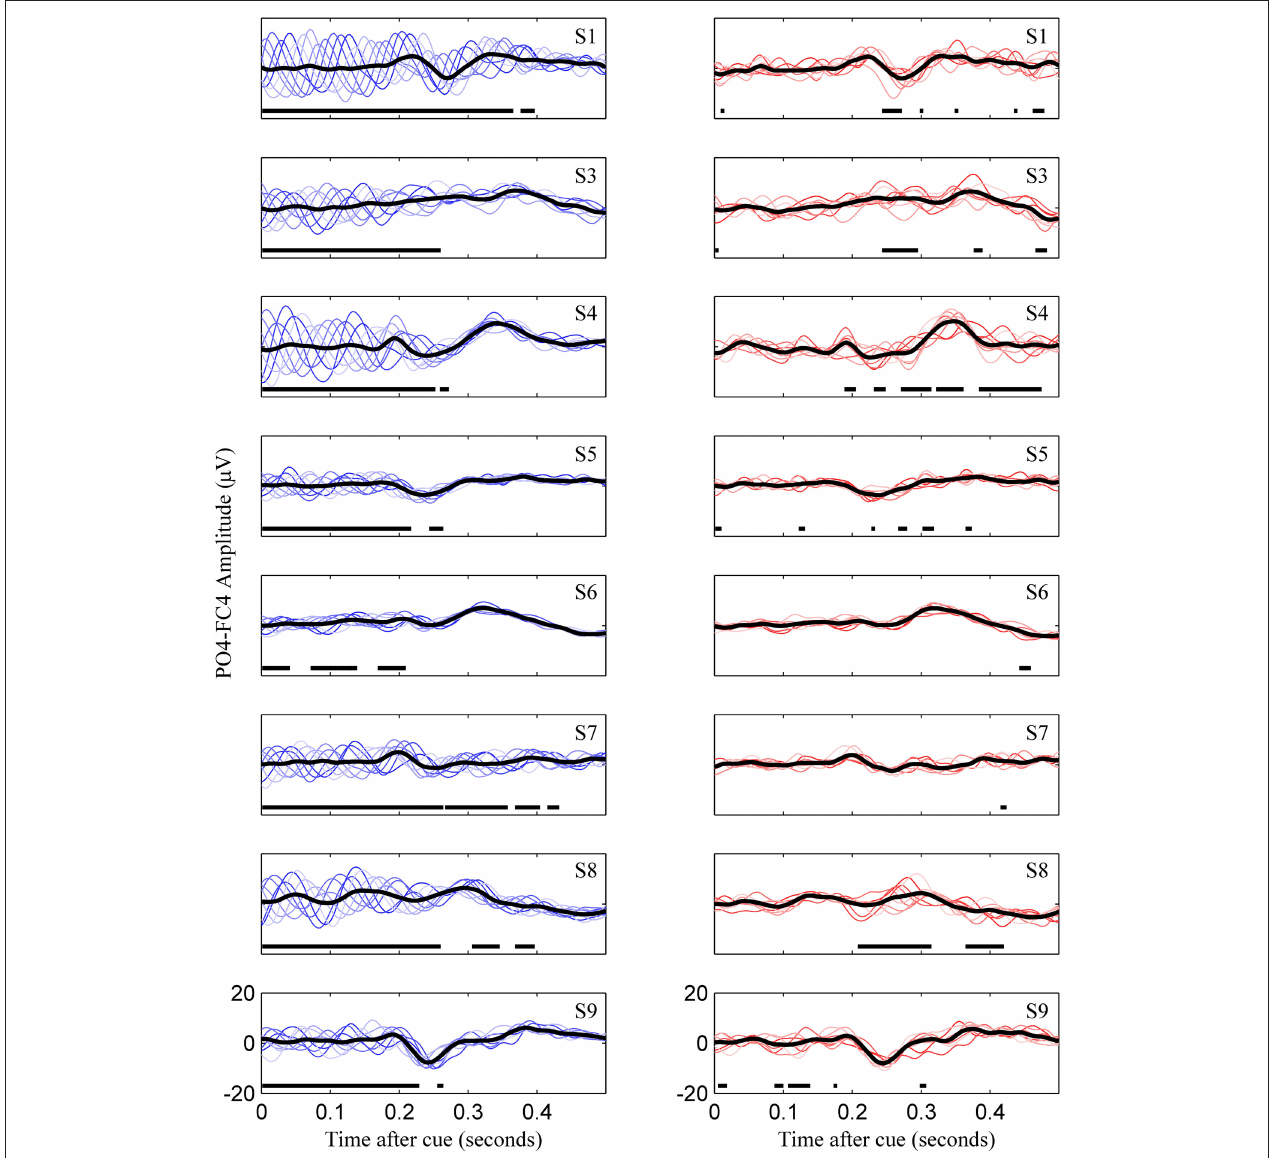
FIGURE 3 | Uncorrected (left) and phase match corrected (right) VEPs for all subjects. This represents for all subjects what is Figures 2E,F for subject 8. Colored lines are the eight phase groups, and the black trace is the resulting average VEP. Regions with thick horizontal lines indicate times during which mean VEPs between the eight phase groups were significantly different as determined by ANOVA ( p < 0.05, Bonferroni